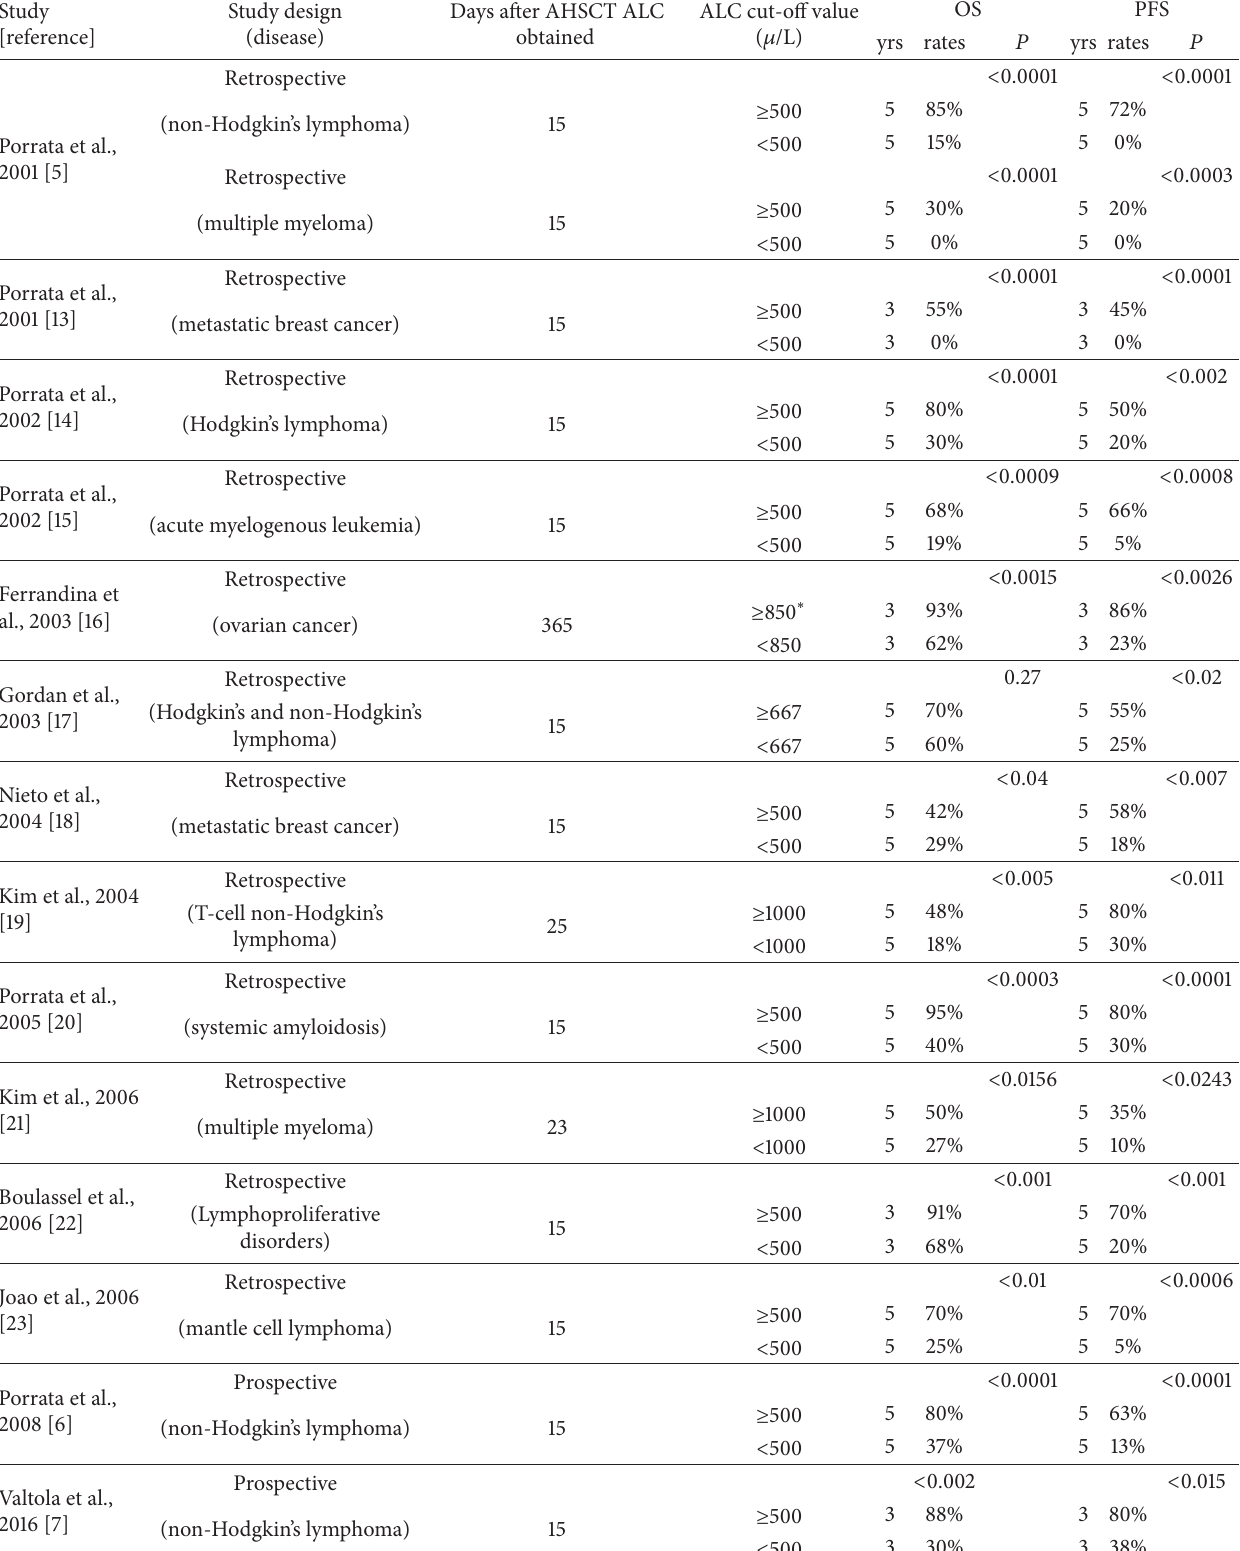
Table 1: Survival outcomes based on absolute lymphocyte count recovery after autologous hematopoietic stem cell transplantation.